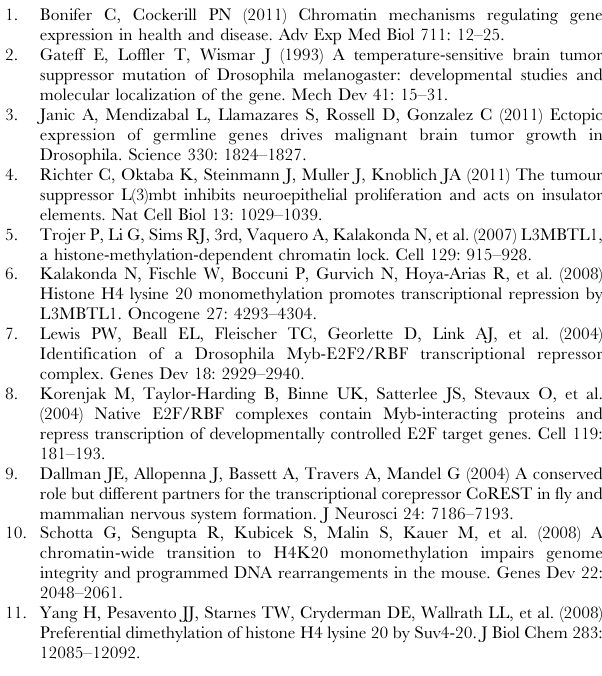
Table S1 dL(3)mbt and dLint-1 bind to germline-specific MBTS and SWH target genes. Genes were visually inspected for Table S2 dL(3)mbt and dLint-1 regulate germline-specific Table S3 Top 50 genes repressed by Lint-1. Table S4 Primer